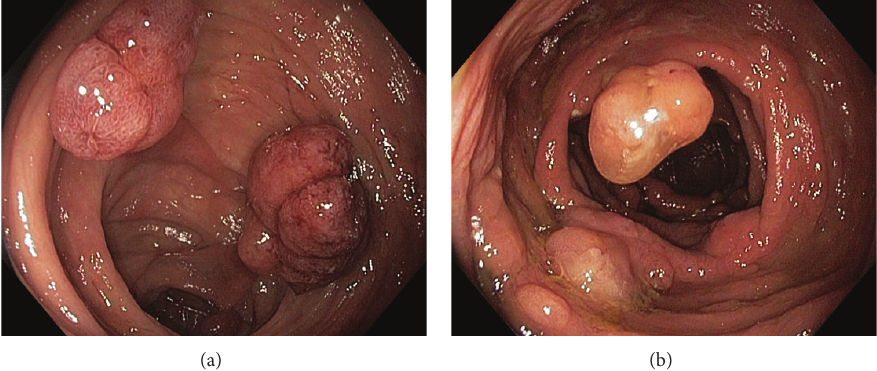
Figure 12: Multiple colonic polyps; juvenile polyps/hamartomas, tubular adenomas, traditional serrated adenomas.